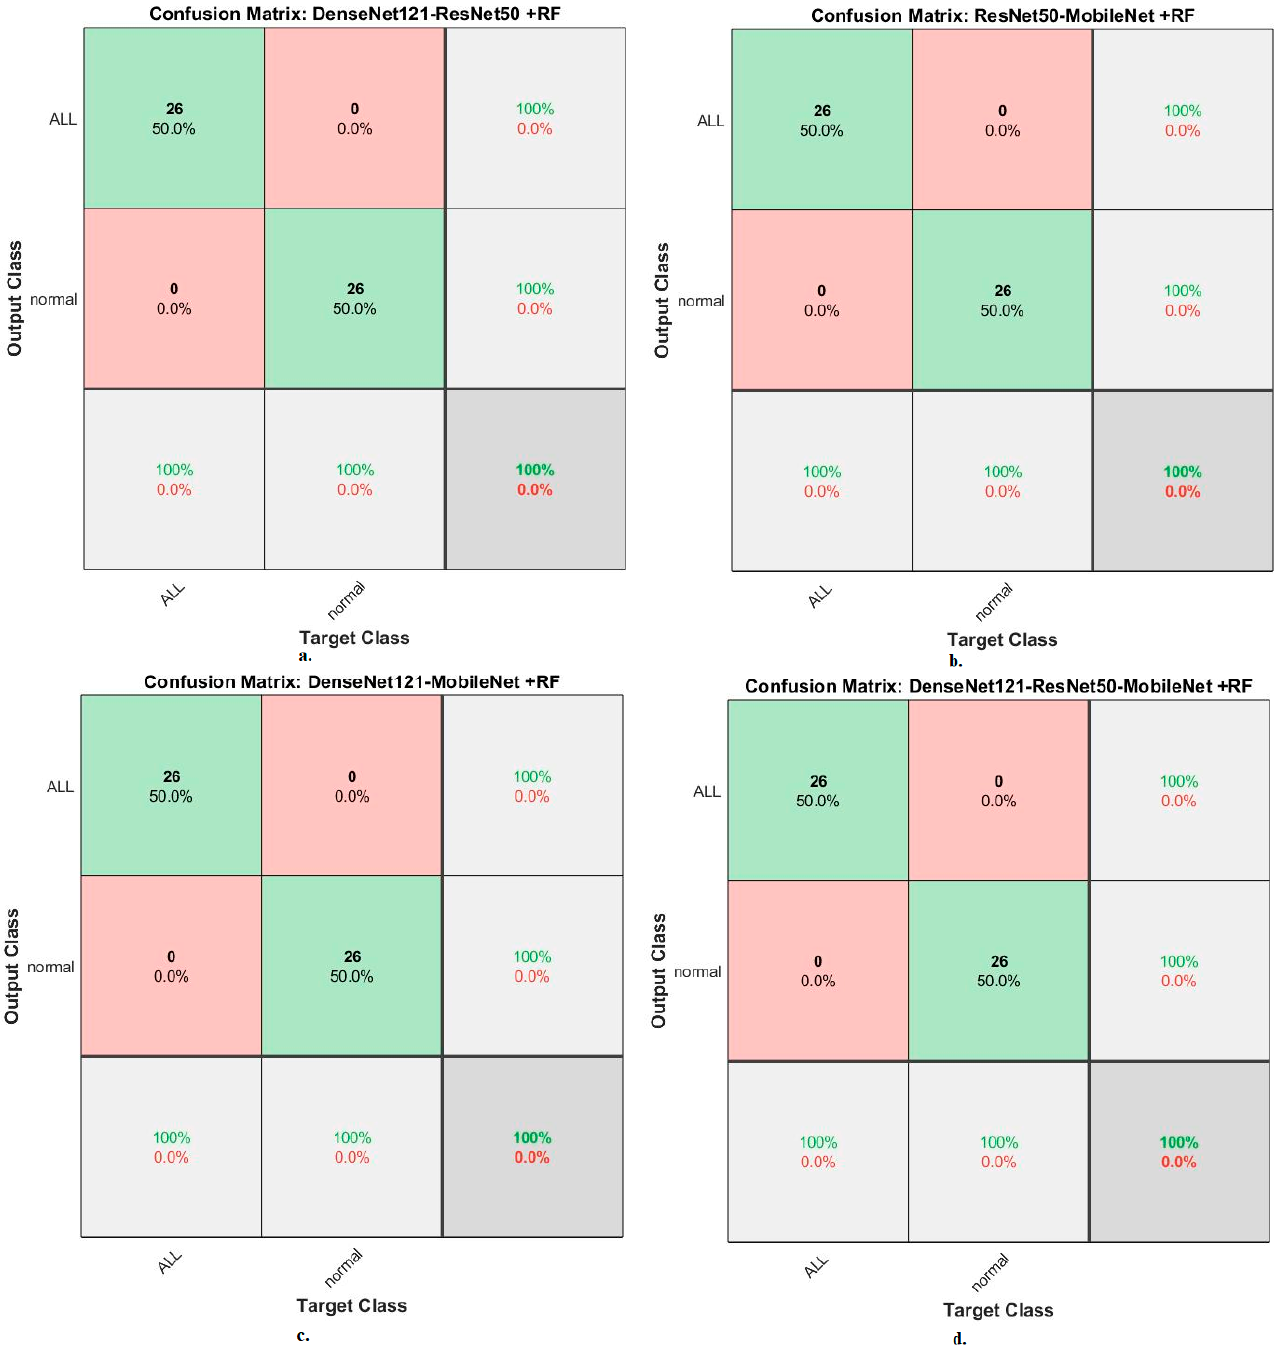
Fourth, DenseNet121-ResNet50-MobileNet-XGBoost achieved an accuracy of 100% and 100% for ALL and normal classes.